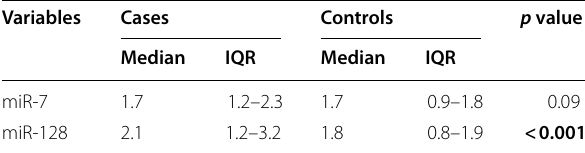
Table 2 MiRNA‑128 and miRNA‑7 expression among studied